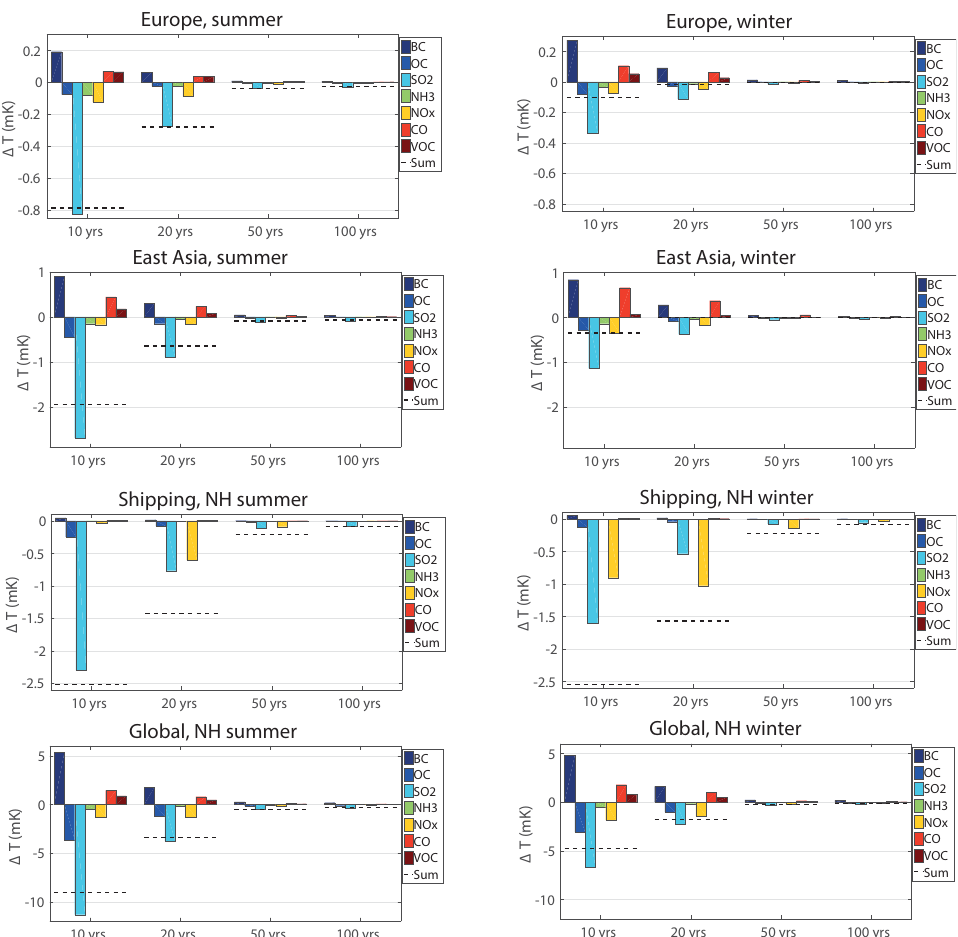
Figure 8. The global temperature response 10, 20, 50, and 100 years after regional and seasonal emissions in 2008. The regions from top to bottom are Europe, East Asia, the global shipping sector, and global. NH summer season (May–October) is to the left and NH winter season (November–April) to the right. Note that the y axis differs between the